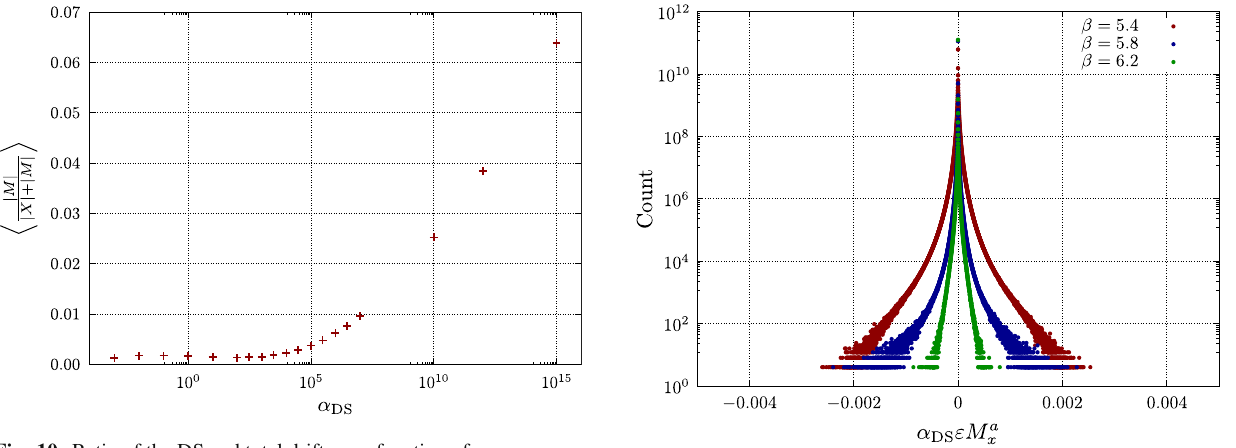
Fig. 11 Histogram of the drift added by DS for different values of the gauge coupling β